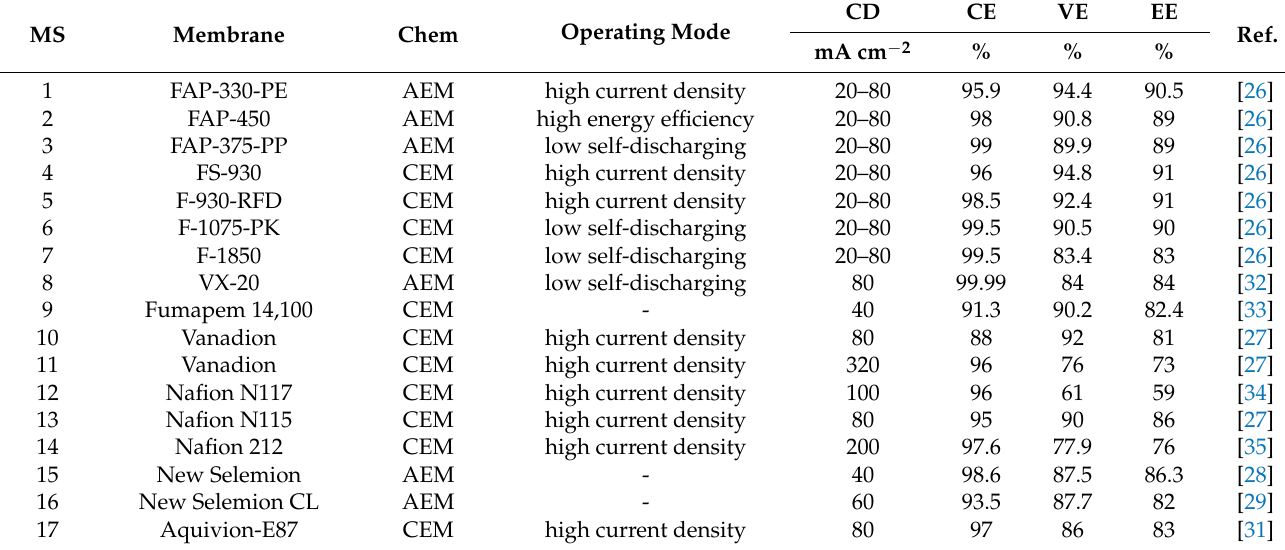
Table 2. Overview of commercial membranes for VRFB: (1–9) FumaTech, (10–14) DuPont, (15, 16) Asahi Glass, (17)